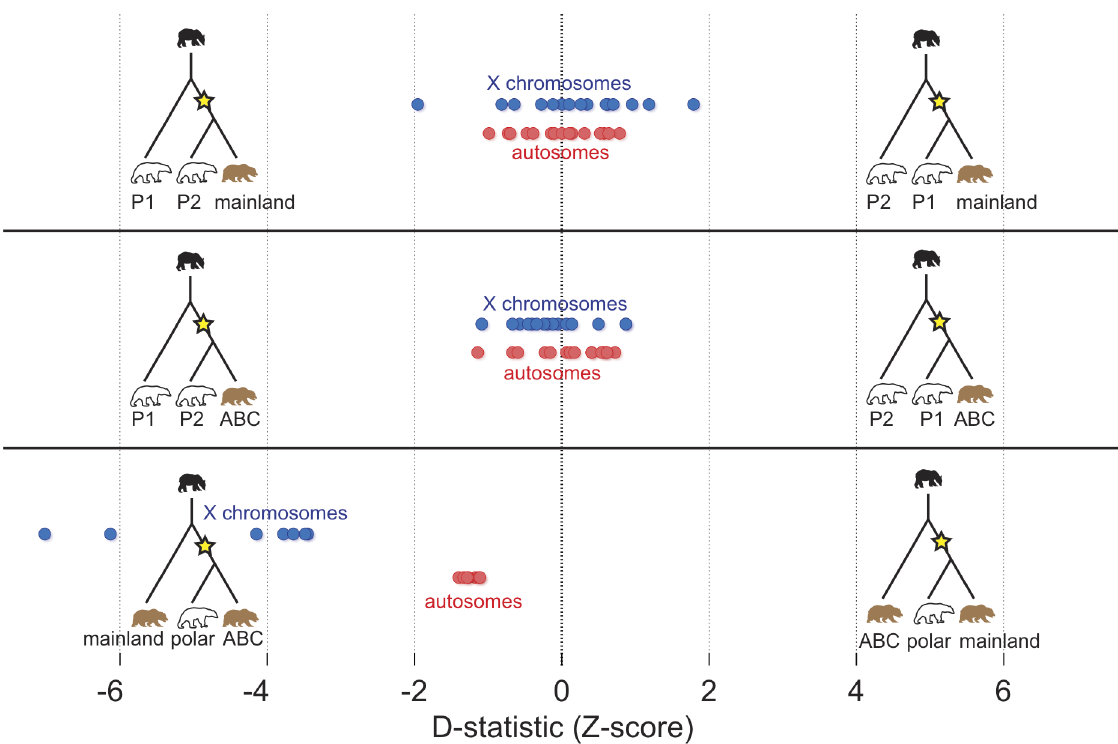
Figure 3. Summary of D-statistic comparisons between polar bears and brown bears. In each comparison, the black bear was used to define the ancestral allele. The Z-score of the D-statistic for each comparison is shown for autosomes (red) and X-chromosome (blue). Each dot represents the data from comparison of one pair of bears. In the top panel, all pairs of polar bears are compared for excess derived allele matching against the mainland brown bear. In the middle panel, all pairs of polar bears are compared against the ABC Island brown bear. The bottom panel shows the comparison of the two brown bears for excess allele matching to polar bears with each dot representing a different polar bear.